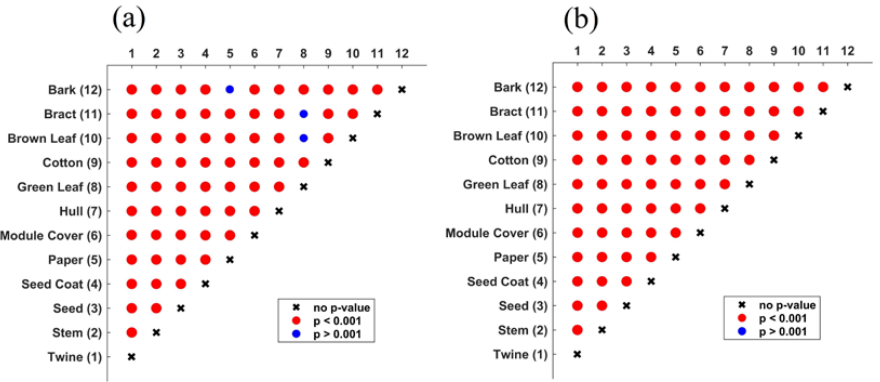
Figure 11. Pairwise p -values returned by Hotelling’s T -squared test performed on different feature sets. ( a ) waveform features; ( b ) amplitude features.